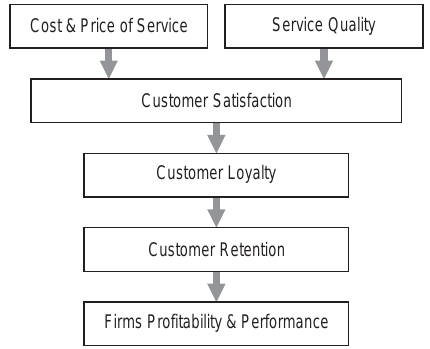
Fig. 2. The relationships among service quality, customer satisfaction, customer loyalty, customer retention